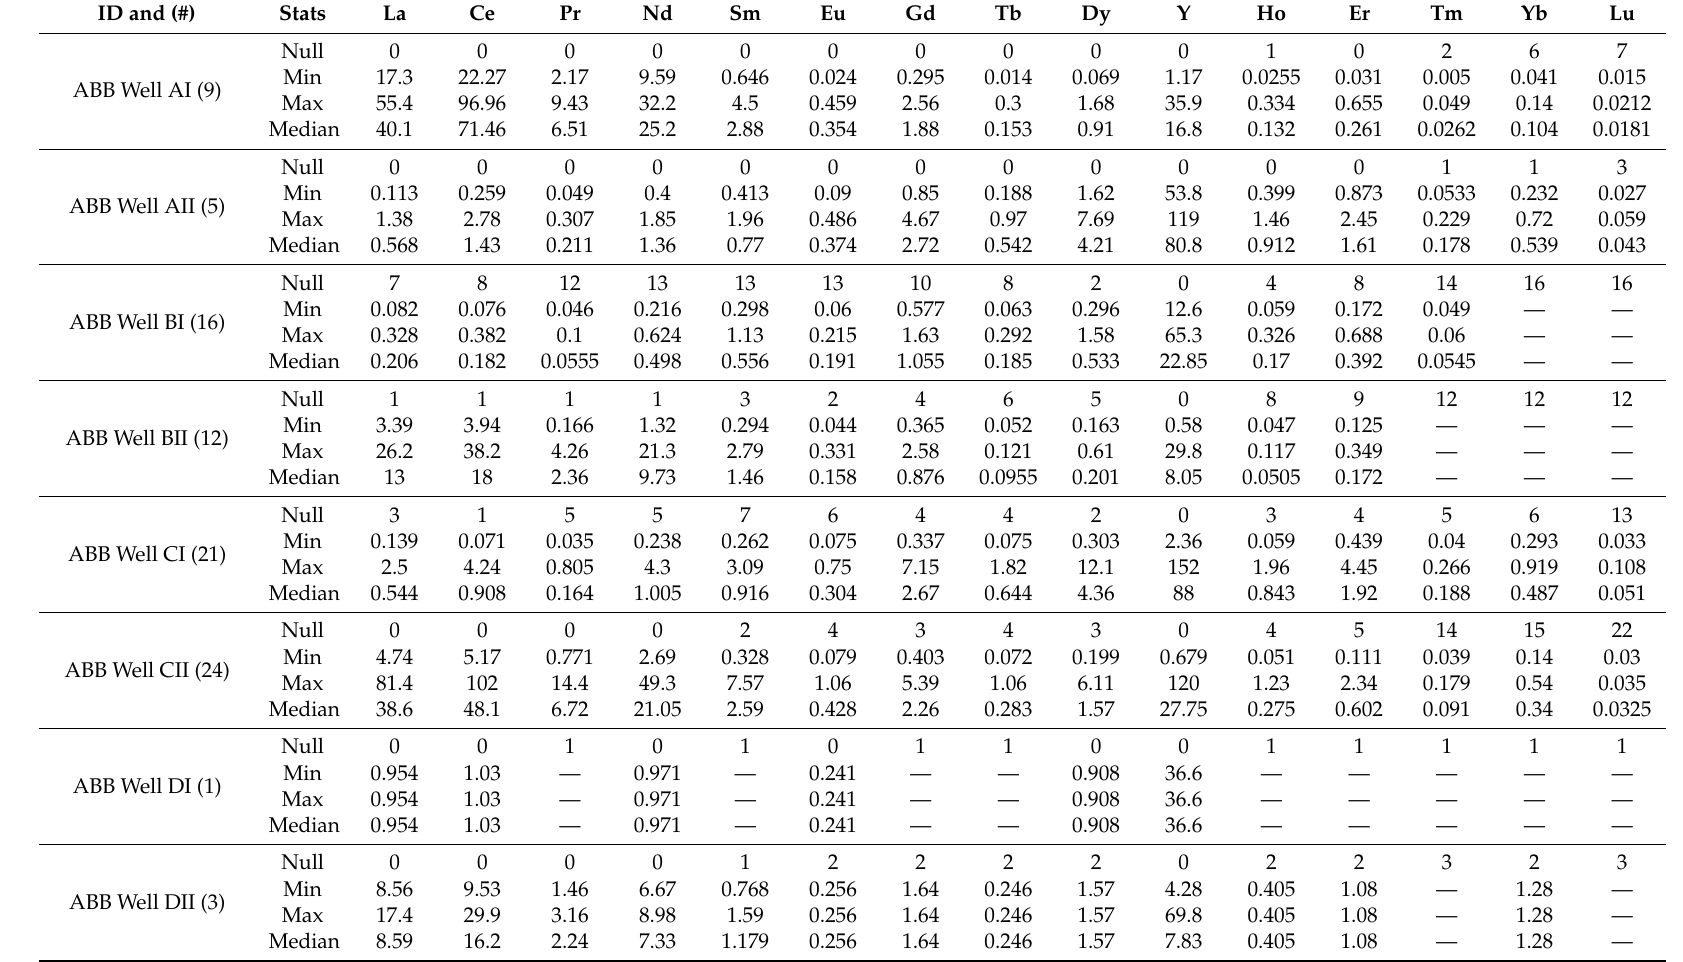
Table 3. REY concentrations in fluorite (polished petrographic mounts) from the investigated areas, including number of in-situ analyses per sample (#), minimum (Min), maximum (Max) and median values. Null represents the number of analyses that returned values below the detection limit. All concentrations in parts per